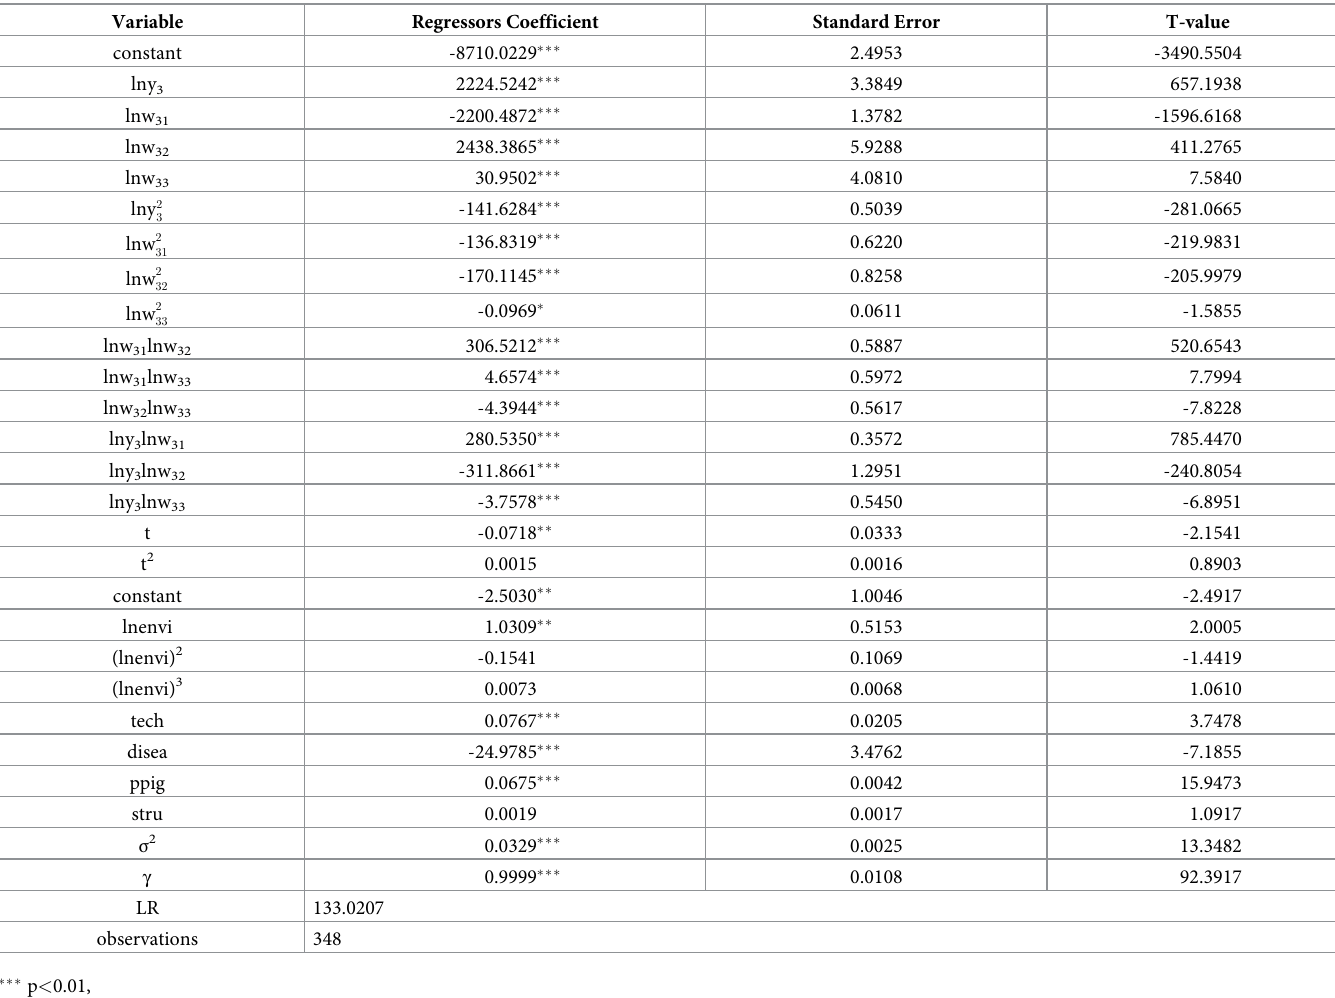
Table 6. Parameters of the translog stochastic cost frontier model for piglets in